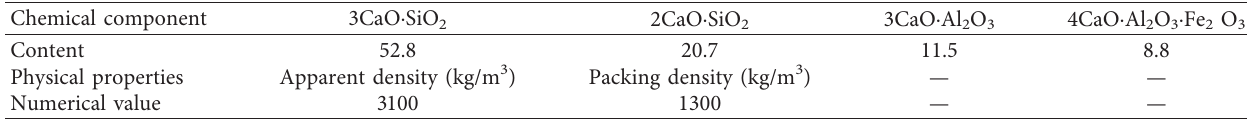
Table 3: Physical parameters of the cement.